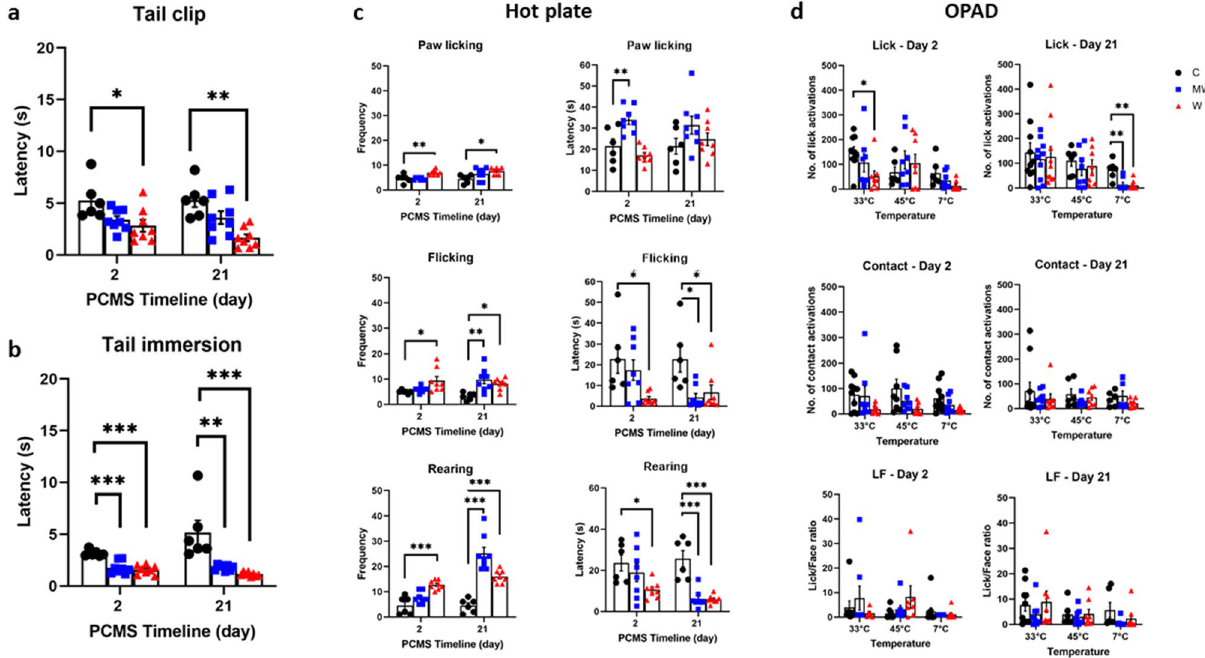
Figure 3. Quantitative sensory testing for pain. The water (W) group had lower mechanical pain threshold on days 2 and 21 of the predictable chronic mild stress (PCMS) based on the results of the tail clip test ( a ). The mesh wire (MW) and W groups were more sensitive to thermal pain on both day 2 and day 21 of the PCMS according to the faster latency in the tail immersion test ( b ). The hot plate test frequency on day 2 and day 21 revealed greater pain for the MW and W groups ( c ). There was noticeable increase in orofacial pain sensations brought about by decrease in the number of licks in the W group at 33 °C on day 2 and in the MW and W groups at 7 °C on day 21. The orofacial pain sensitivity was assessed using the orofacial pain assessment device (OPAD) ( d ). N = 6–8 per group (tail clip, tail immersion, and hot plate); N = 8–10 per group (OPAD); * p < 0.05, ** p < 0.01, *** p < 0.001; one-way ANOVA followed by Dunnett’s or Tukey’s multiple comparison test. Data are presented as means ±